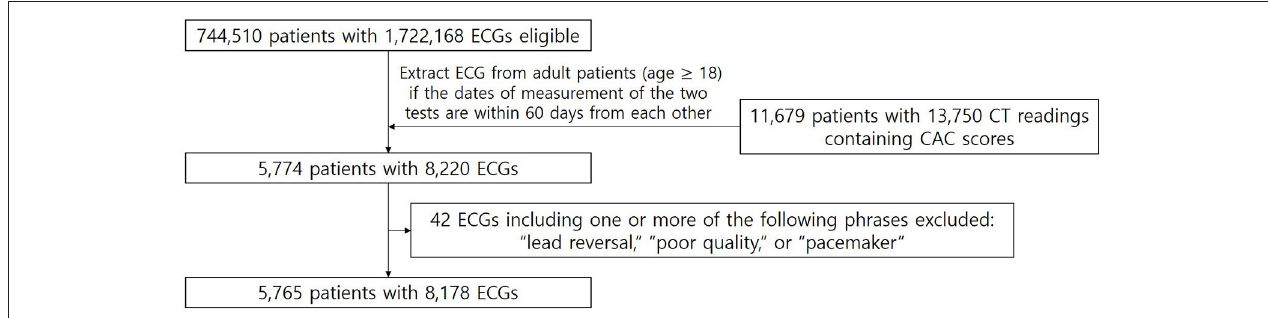
FIGURE 1 | Patient flow diagram of the training and internal validation dataset from AUMC. From the AUMC ECG database, after applying the exclusion criteria, the number of ECGs measured within 60 days before or after the CT readings containing CAC scores was 8,178 ECGs from 5,765 adult patients.